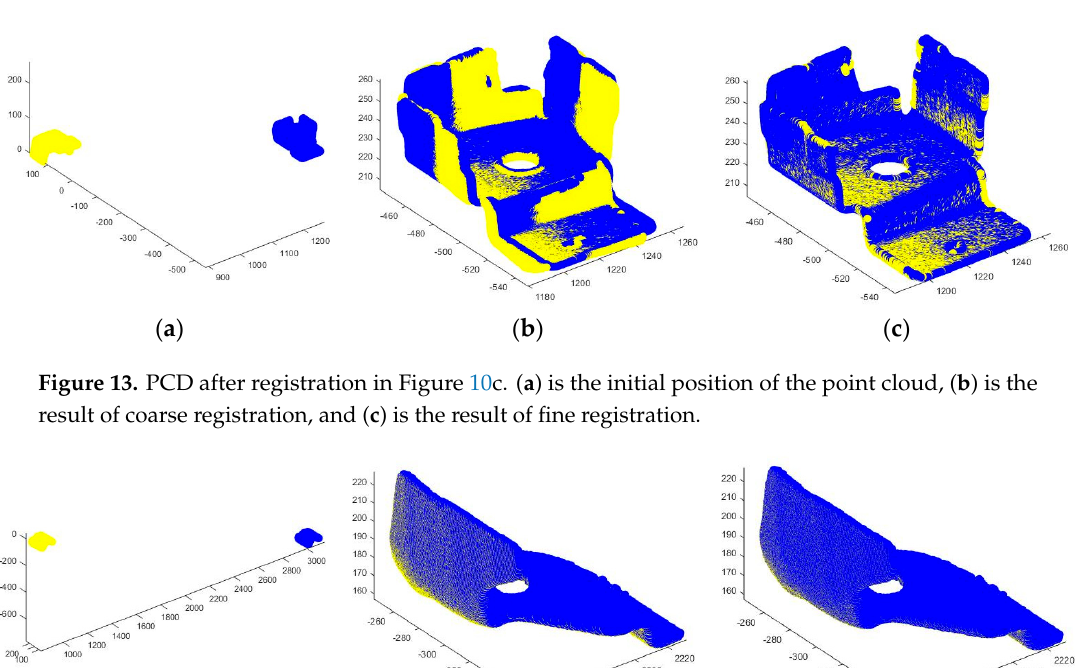
Figure 12. PCD after registration in Figure 10b. ( a ) is the initial position of the point cloud, ( b ) is the result of coarse registration, and ( c ) is the result of fine registration.